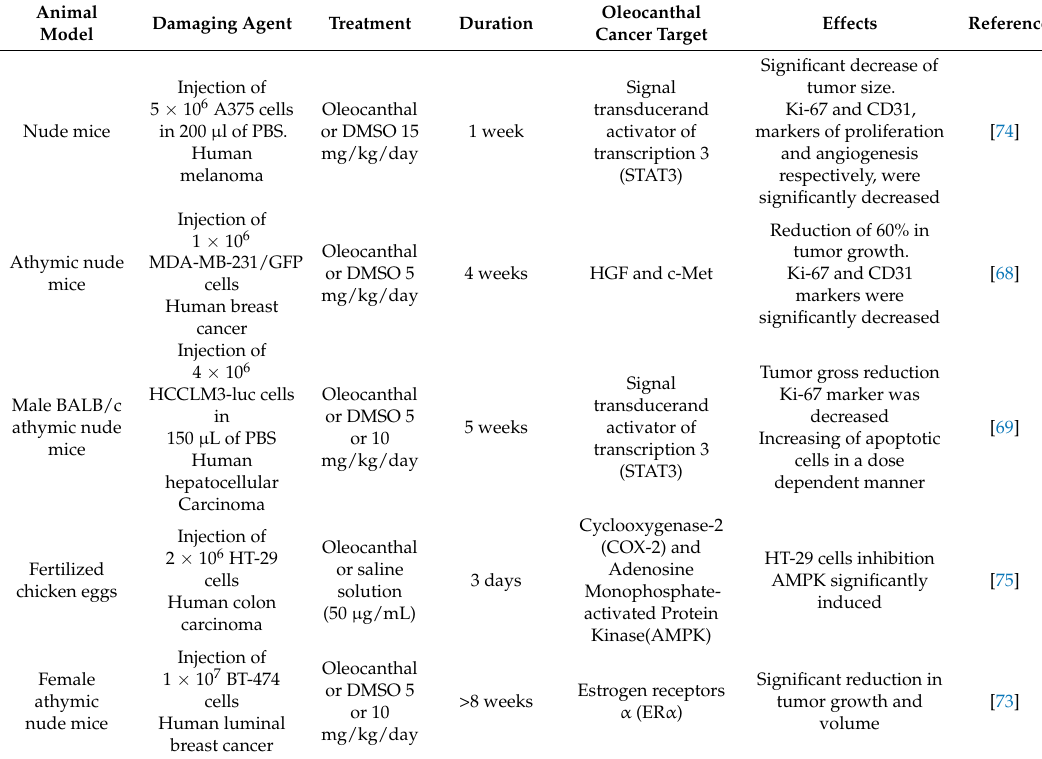
Table 2. Characteristics of selected in vivo studies showing anti-cancer effects of oleocanthal. Animal